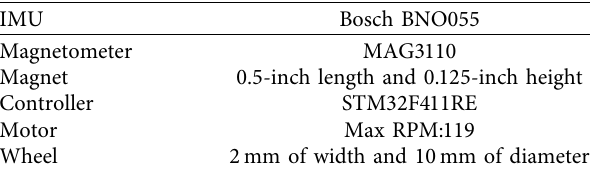
Table 1: Mechanical parameters of the robot.